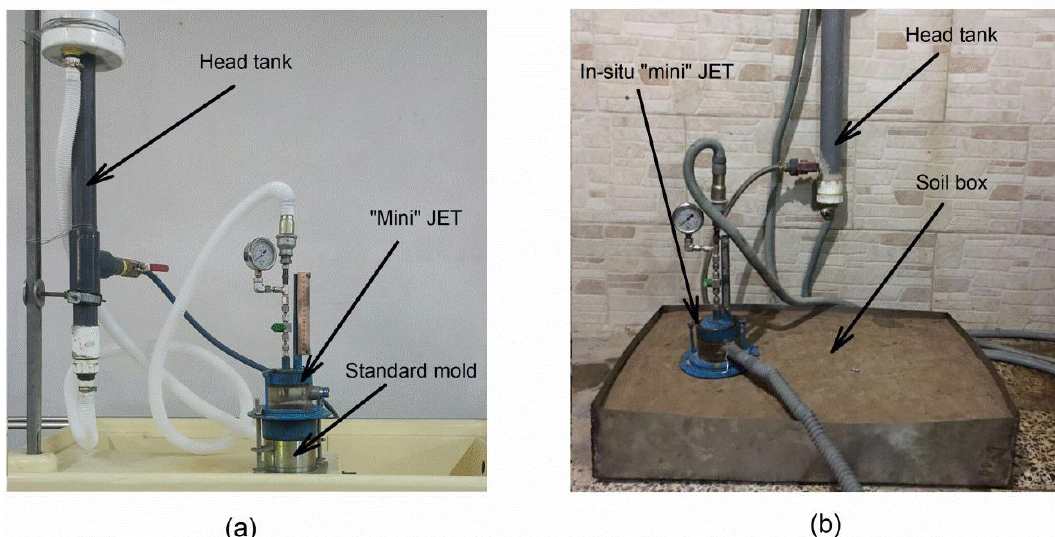
Figure 3. Jet Erosion Test (JET) device setup for ( a ) small-scale and ( b ) large-scale.